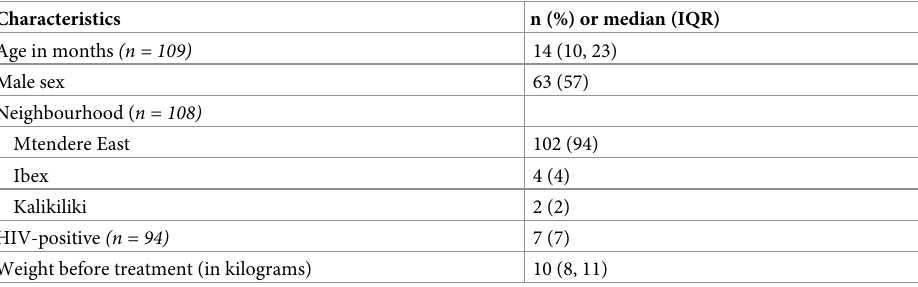
Table 2. Characteristics of study population (n =